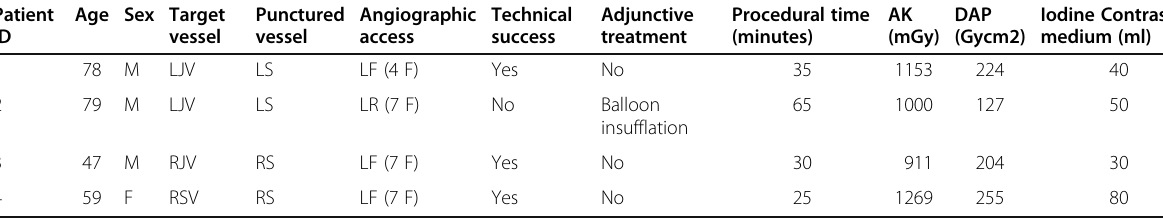
Table 1 Systematic overview of all